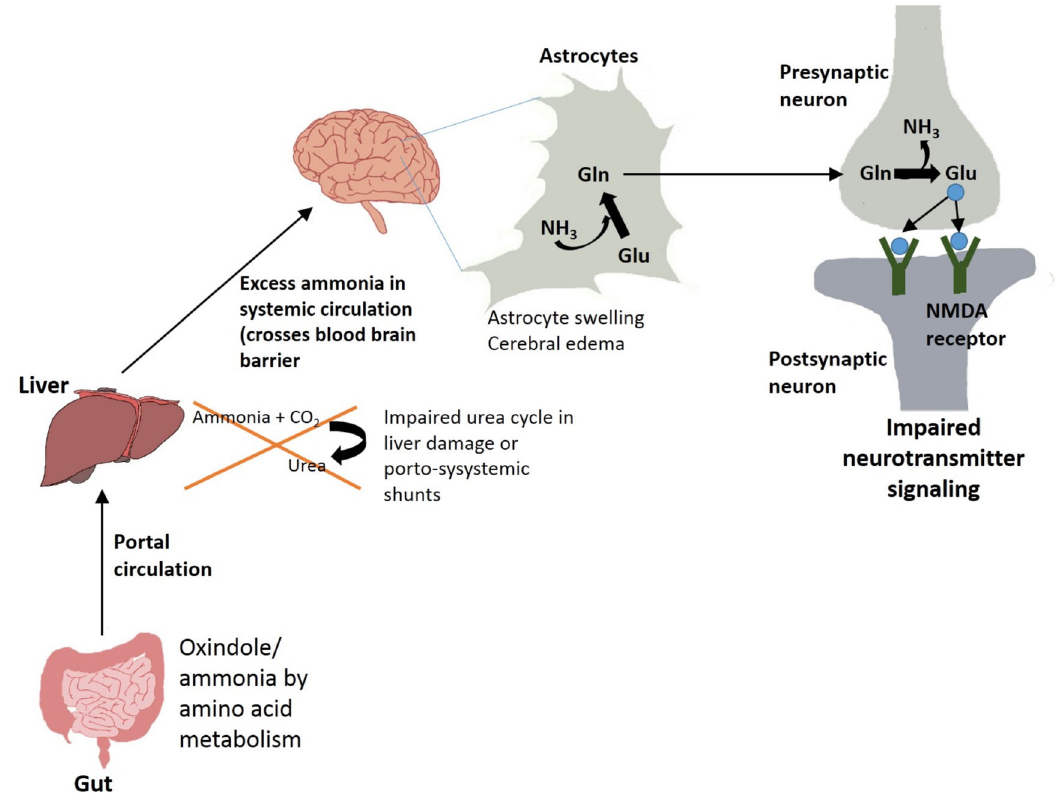
Fig. 3 Gut – Liver – brain axis. Impairment of liver urea cycle in liver disease condition leads to increase in uremic toxins and ammonia which reach the brain and affect neurotransmitter signaling and astrocyte